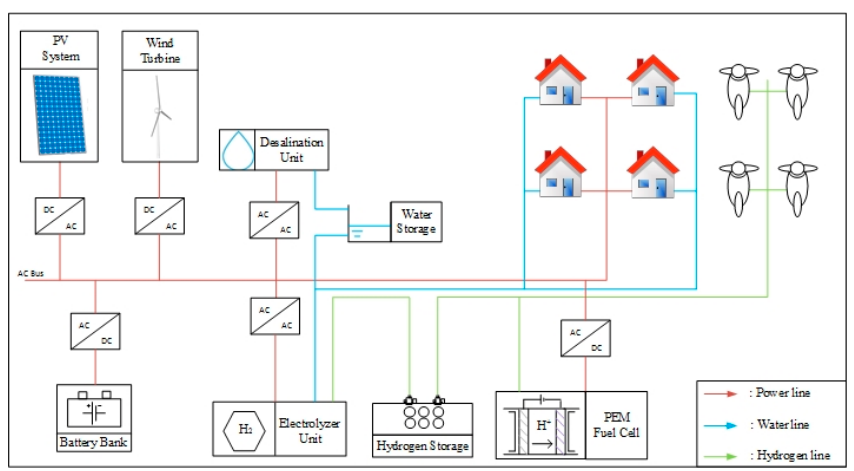
Figure 1. Schematic representation of the microgrid configuration.